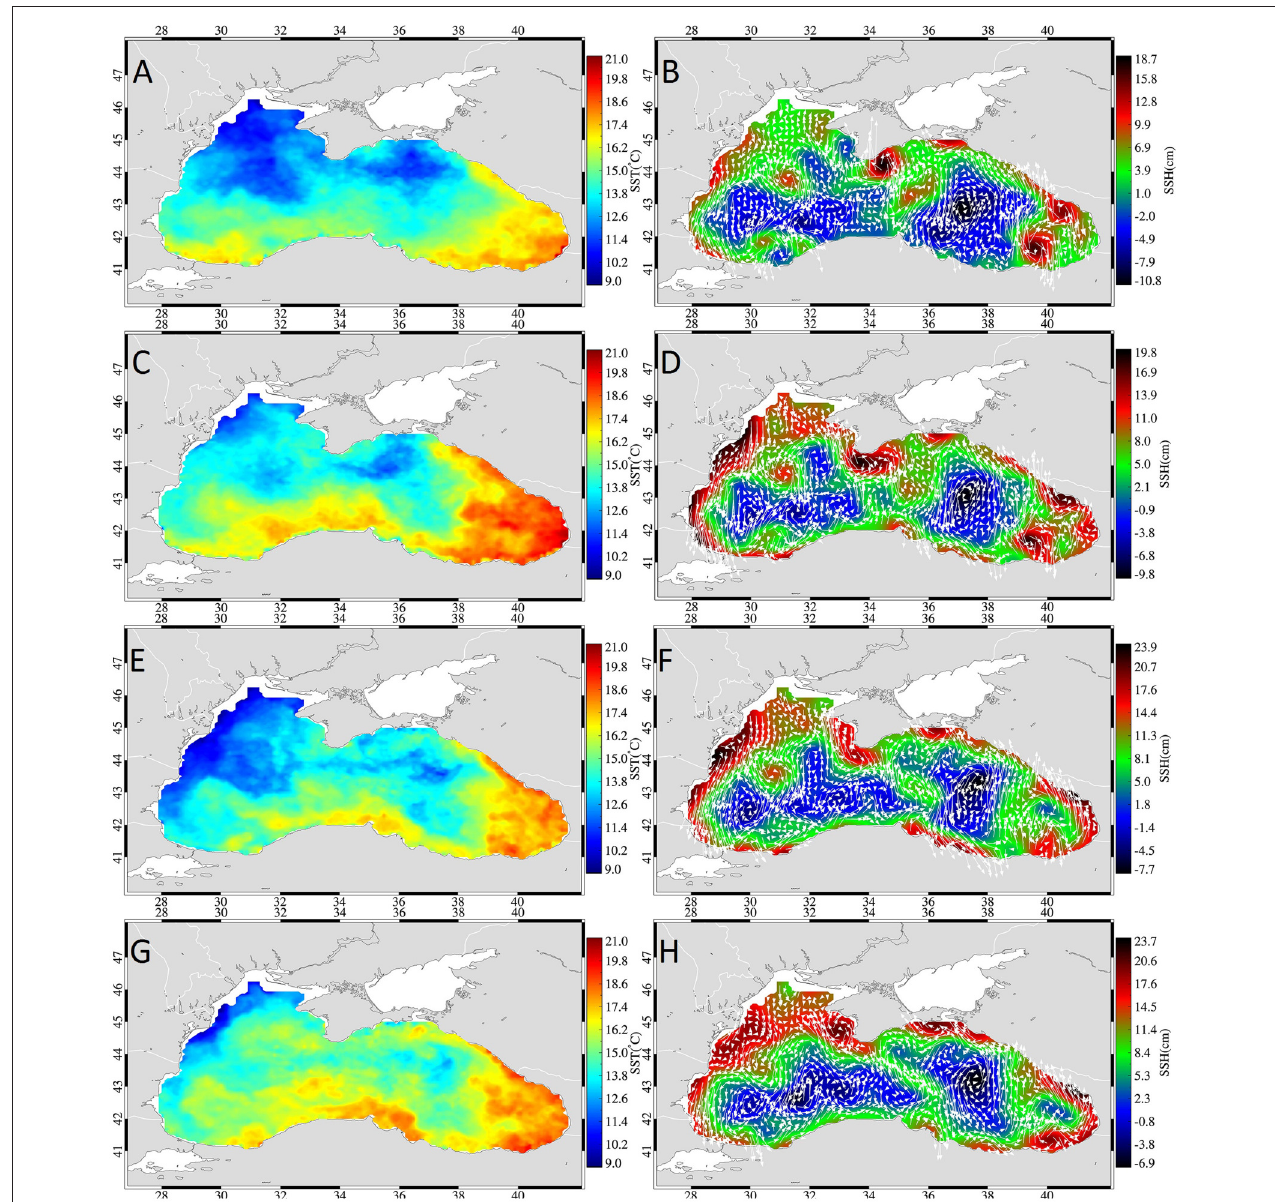
FIGURE 6 | Weekly mean sea surface temperature (left) sea surface height fields (right) overlaid with geostrophic currents (white arrows) during week 1 (A,B) , 2 (C,D) , 3 (E,F) , and 4 (G,H) of November 2003.